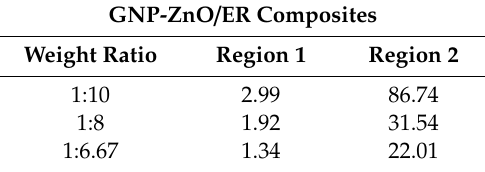
Table 1. Nonlinear coe ffi cients of GNP-ZnO / ER specimens filled with various weight ratios of GO to Zn(Ac) 2 .